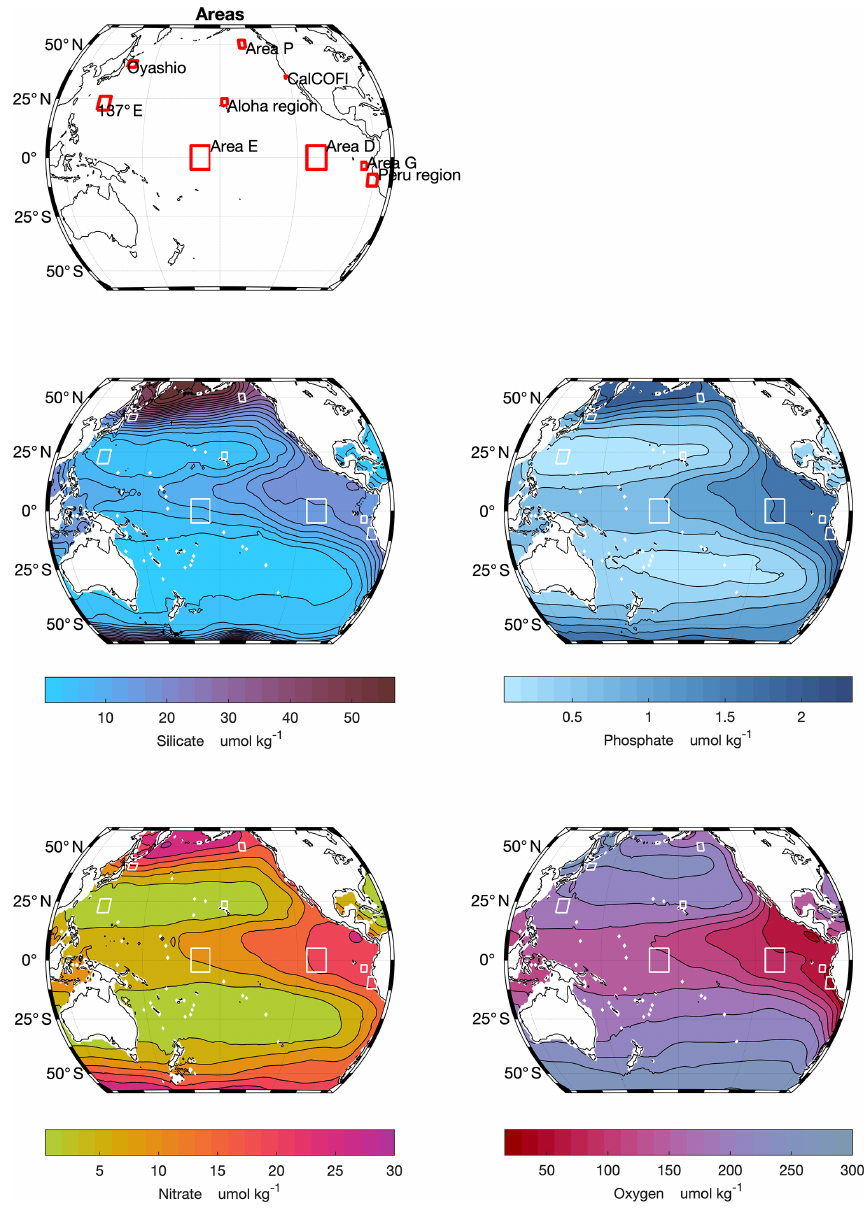
Figure 2. Distribution of the areas used and mean 50 to 300m silicate, phosphate, nitrate and oxygen (all in micromoles per kilogram), in the Pacific